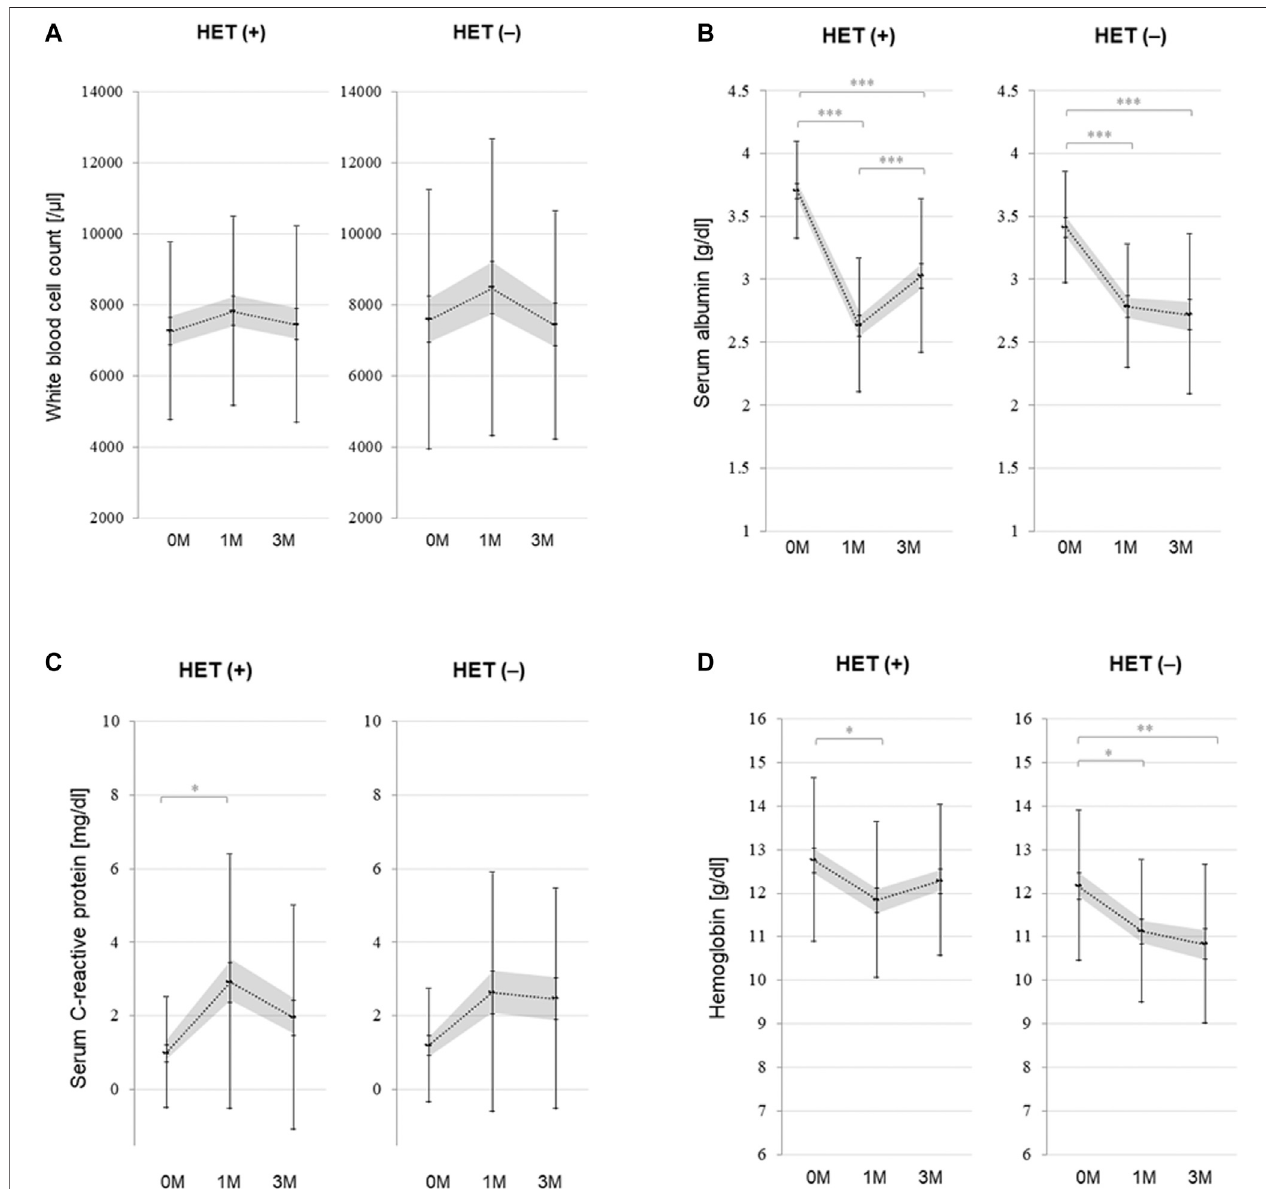
FIGURE 2| Changes in the blood biomarker levels in the patients ofHET and non-HET groups. Changes in the white blood cell count (A) , serum albumin level (B) , serum C-reactive protein level (C) , and hemoglobin level (D) in the patients of HET and non-HET groups. The dotted lines show the change in average. Error bars